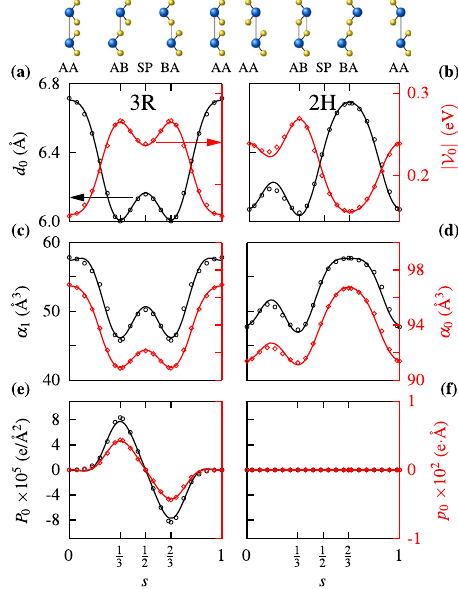
Fig. 2 Parameterization of Eq. (2) along the con fi guration space diagonal for 3R- and 2H-stacked bilayer MoS 2 . a , c , e 3R-stacked bilayer MoS 2 : a d 0 (black) and V 0 j j (red); c α 1 (black) and α 0 (red); e P 0 (black) and p 0 (red). The hollow markers are results from fi rst- principles calculations, and the solid curves show the corresponding Fourier interpolations. Black refers to the leftmost vertical axis and red to the rightmost vertical axis. The con fi gurations AA s ¼ 0 ; 1 ð above the plots. b , d , f The same quantities, computed for 2H